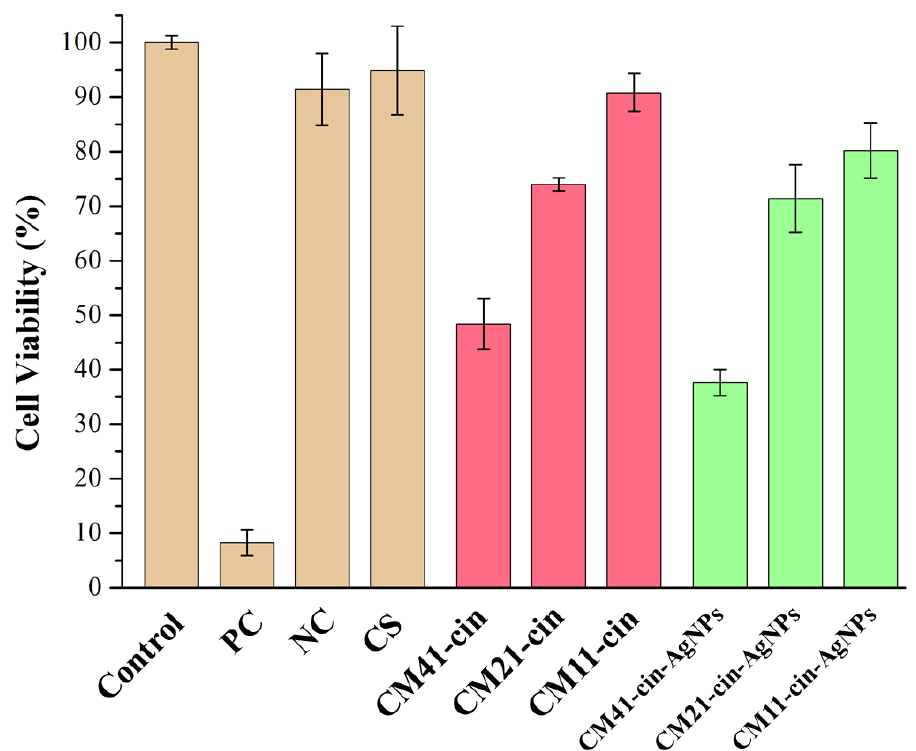
Figure 8. The cell viability results of the eluents from different specimens. Control: cell culture medium; PC: positive control, latex glove; NC: negative control, LDPE film ( n = 3).